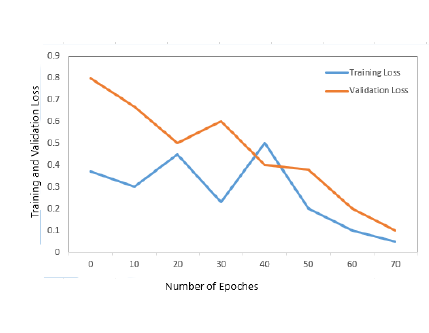
Figure 13. Loss in ResNet15